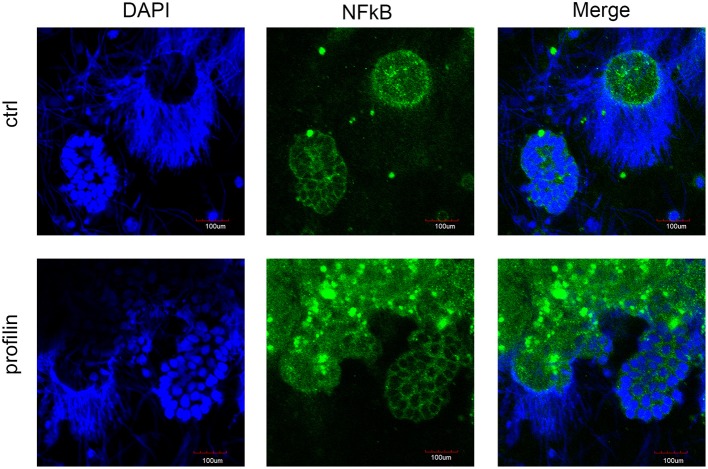
Confocal microscopy of NF-κB localization in seminal vesicles smears. Confocal microscopy showed the distribution of NF-κB p65 by immunofluorescence staining in control tissue and in tissue stimulated with profilin antigen. Blue corresponds to nuclear staining by DAPI and green corresponds to NF-κB p65 staining with antibody against NF-κB p65. Original magnification under ×40. After the stimulation with profilin, NF-κB was not translocated to the nucleus suggesting it is not involved in the signaling pathway via NF-κB. Scale bars represent 100 μm. Strongly stained spots correspond to the presence of melanin in cells.